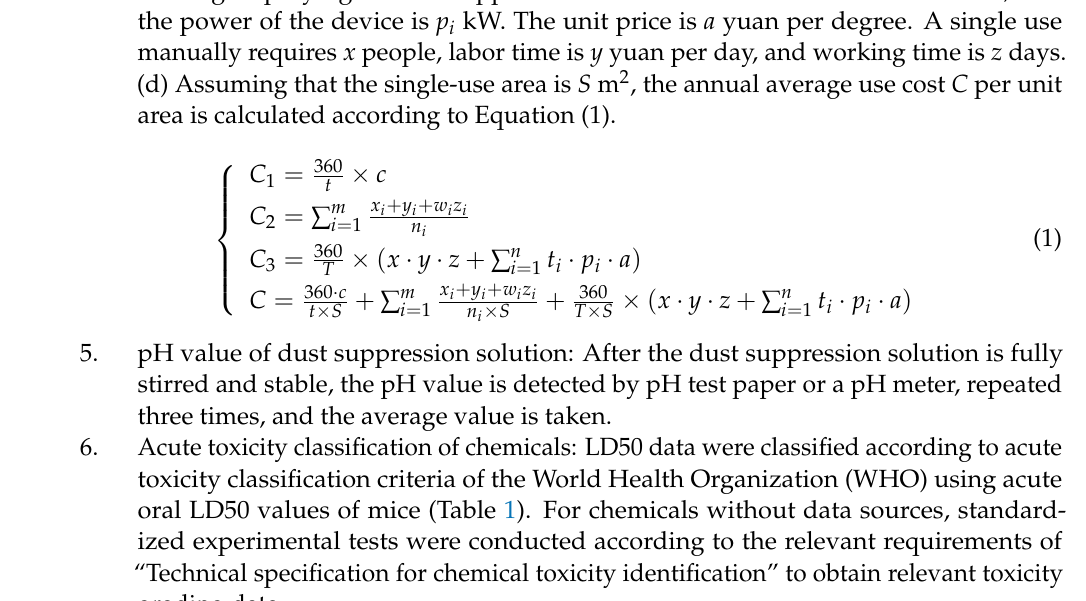
Figure 4. Schematic diagram of surface wind erosion rate experiment. 4. Annual average use cost per unit area: material cost, equipment cost, and operation cost. (a) Material cost C 1 : The effective action time of a single dust suppressant is t days, the single-use cost is c yuan, and the value is 360 days per year. (b) Complemen- tary equipment cost C 2 : For m sets of required equipment, the service life of the first equipment is n i years, the purchase cost of equipment is x i yuan, the transportation and installation cost is y i yuan, the maintenance time is w i , and the average single maintenance cost (e.g., labor costs) is z i yuan per time. (c) Operation cost C 3 : The spraying period of dust suppressant is set to T days, and n devices are necessary for single spraying of dust suppressant. The i -th device is used for ti hours, and the power of the device is p i kW. The unit price is a yuan per degree. A single use manually requires x people, labor time is y yuan per day, and working time is z days. (d) Assuming that the single-use area is S m 2 , the annual average use cost C per unit area is calculated according to Equation (1).